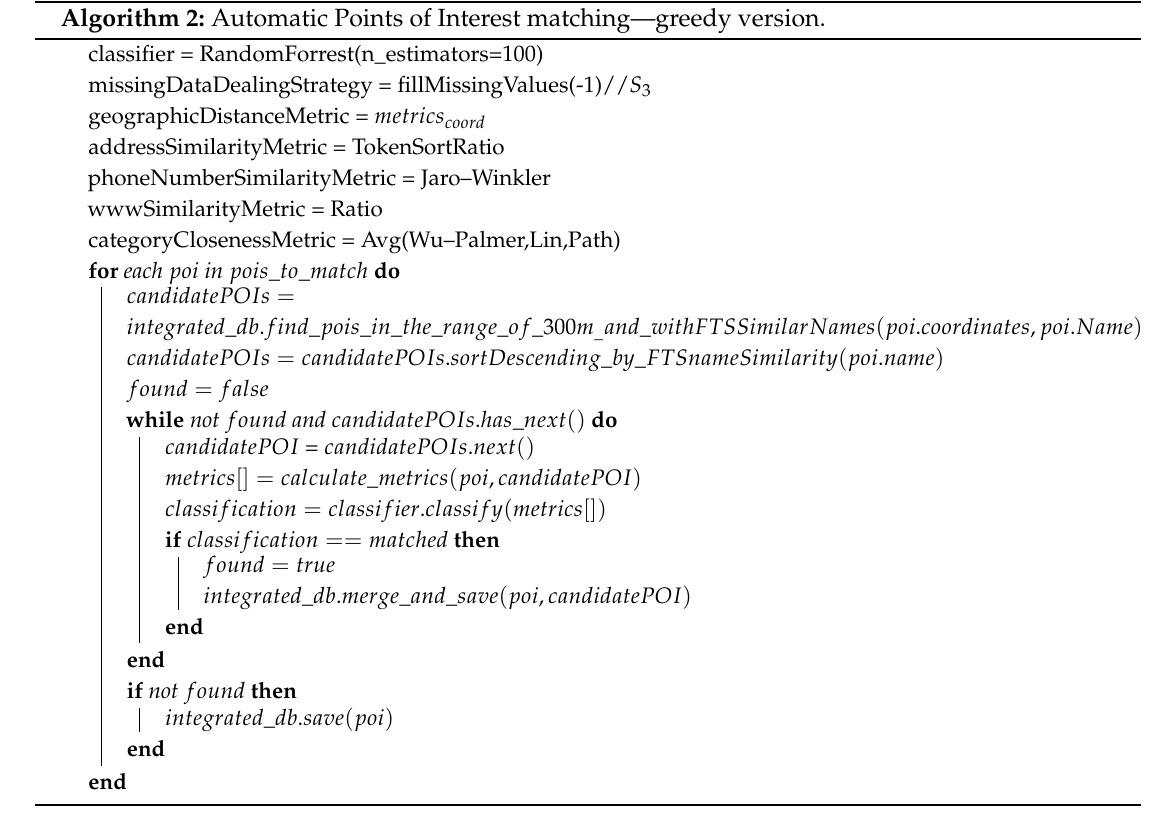
Table 4. A comparison of the precise and greedy versions of the algorithm for automatic Points of Interest matching run on the validation